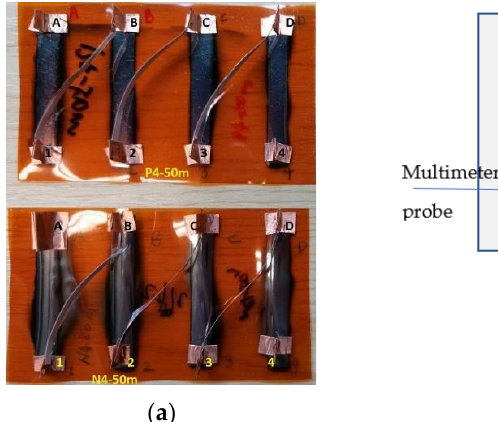
( f ) Figure 3. P-type BiSb 2 Te 3 thin film deposited on silicon wafer: ( a , d ) P4, ( b , e ) P45, ( c ) P5, and ( f ) P6. As shown in Table 2, both the N-type and P-type materials have a higher sputter rate, and it took only 40 min at 0.4 A to obtain a 2.0 µ m thick N-type thin film. The deposition rate for P-type was slightly slower, as it took 50 min at 0.4 A to obtain only a 1.8 μ m thick film. When the current was increased, the deposition was faster, but a higher current than